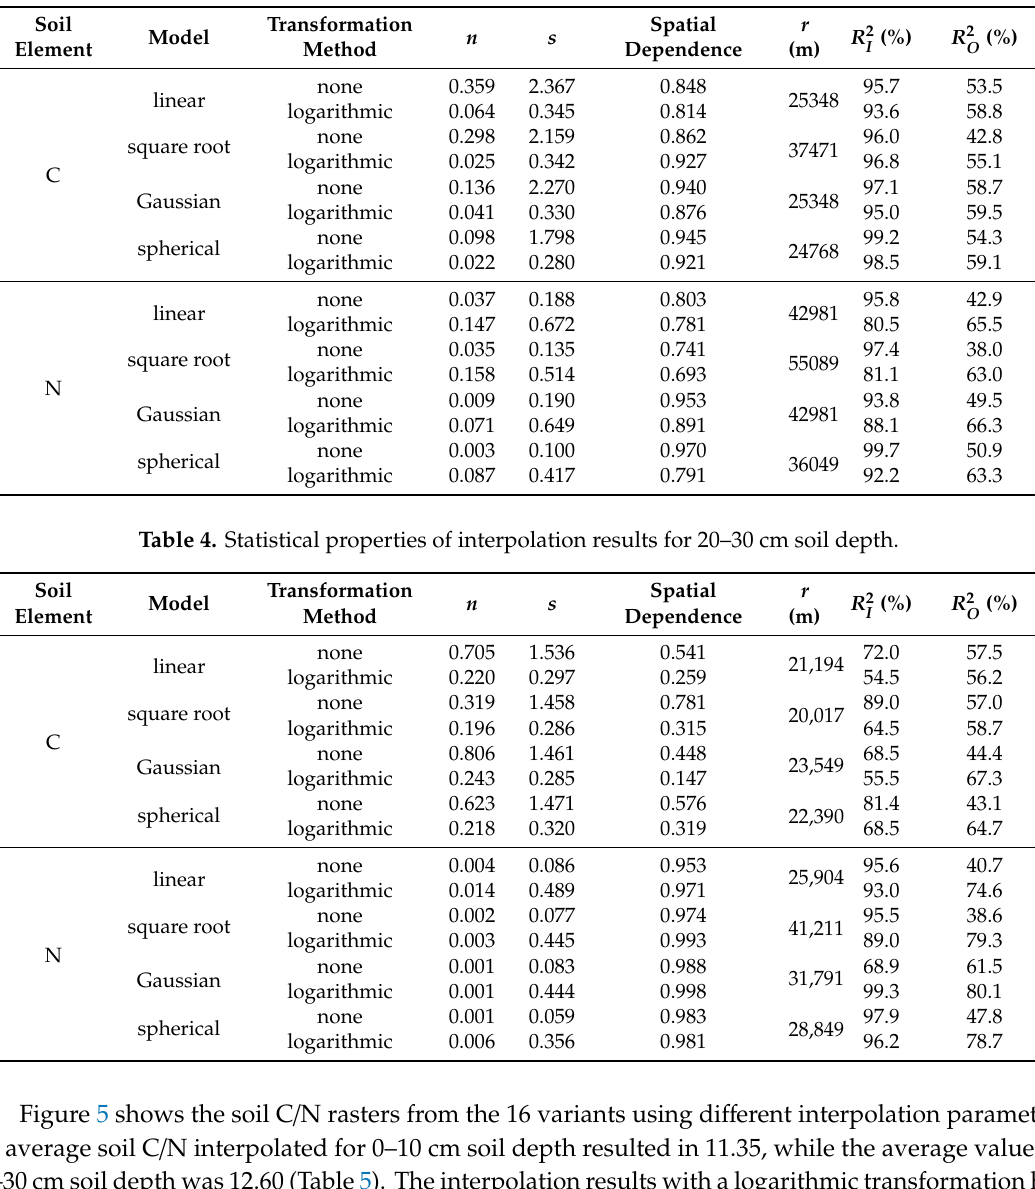
Table 3. Statistical properties of interpolation results for 0–10 cm soil depth.